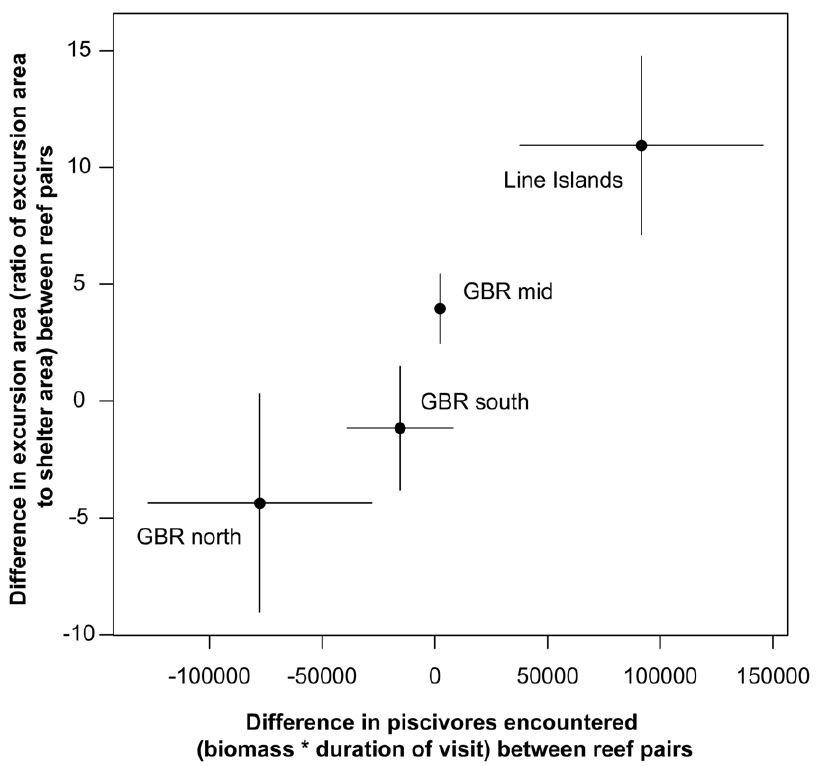
Figure 5. Differences in prey ( P.dickii ) movement in relation to differences in piscivorous fishes encountered between reef pairs. Points ( 6 SE) represent differences in both independent and dependent variables between paired reefs in each of the four regions included in the study. Note that differences were calculated as unfished - fished reef values for x-axis (predation risk) and fished - unfished reef values for y-axis (prey behavior) for the reason outlined in Materials and Methods above.